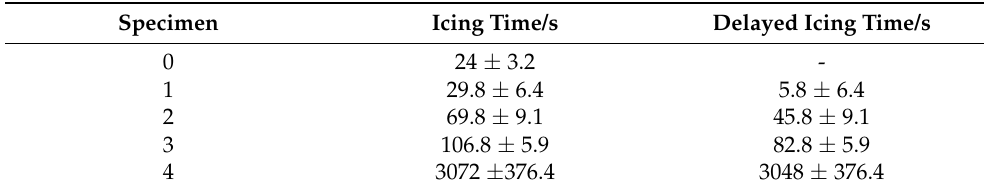
Table 2. Icing time and delay icing time of specimens.